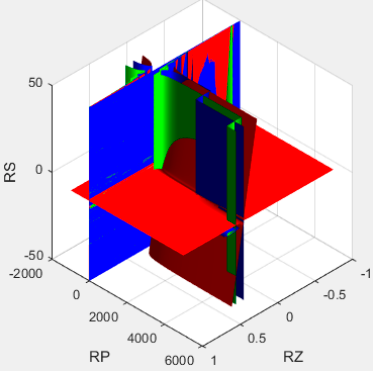
Figure 10. Solving equations by plotting the parameter space in MATLAB.